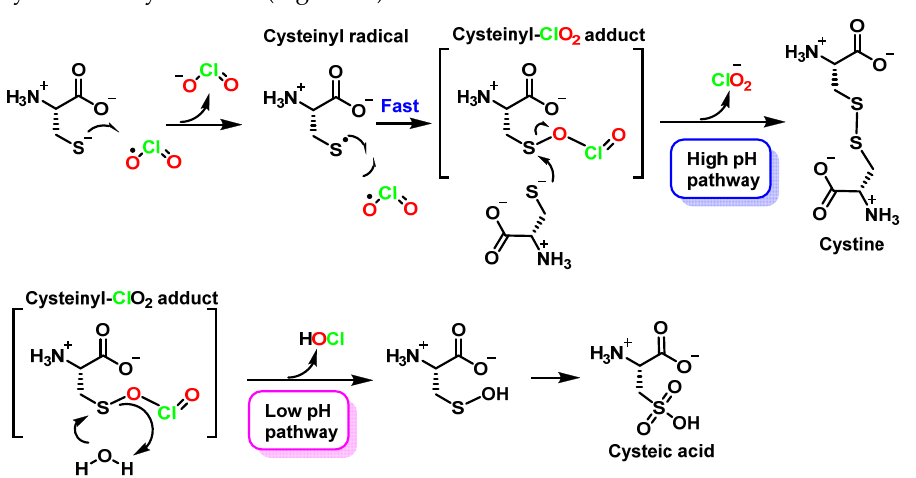
Figure 37. Proposed mechanism for the reactions between ClO 2 and cysteine.